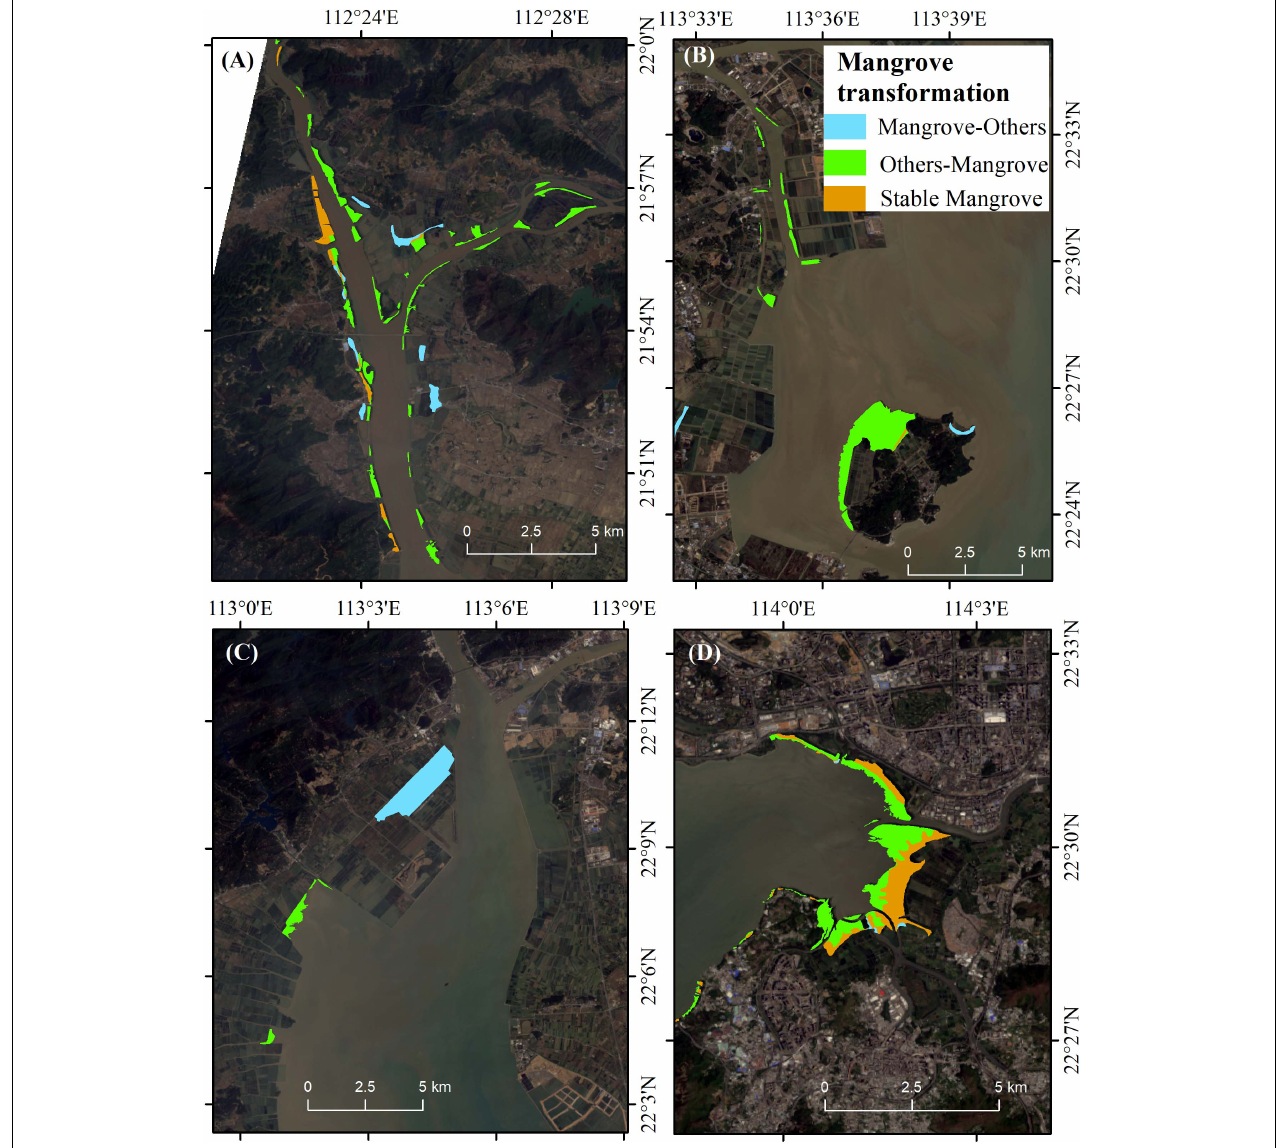
FIGURE 4 | Distributions of three transformation modes of estuarine mangrove sites between 1990 and 2018. (A) Site A; (B) Sites C and D; (C) Site B; (D) Sites E and